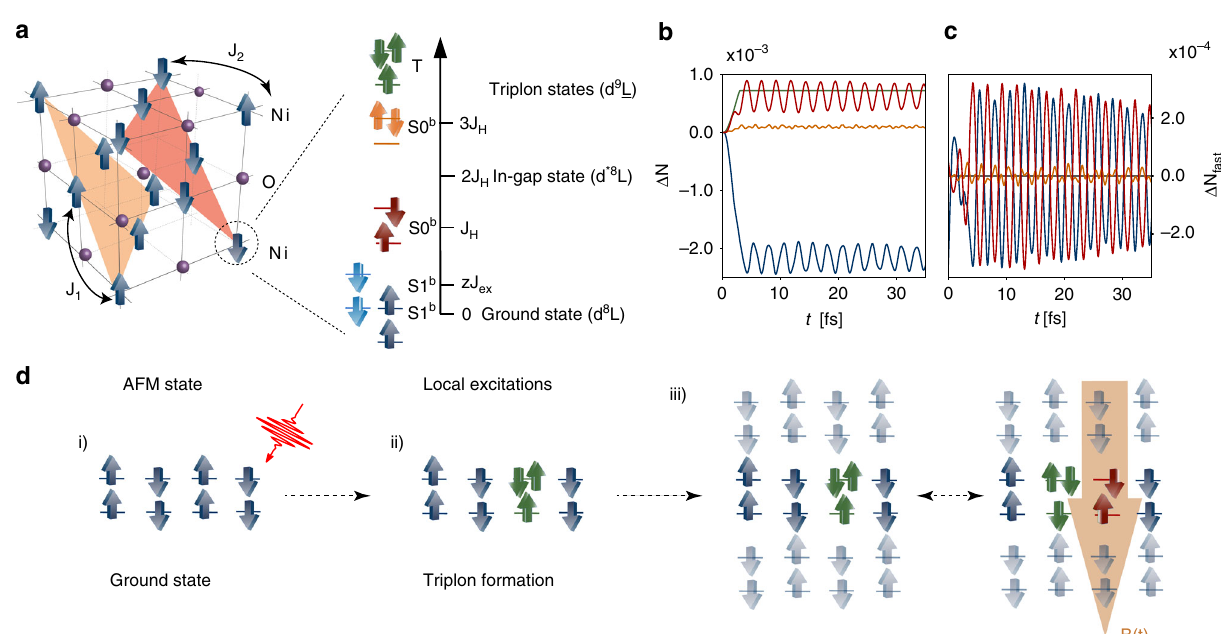
Fig. 5 Coherent many-body dynamics. a Schematic view of the NiO lattice structure with FM exchange J 1 between the nearest-neighbor spins and AFM exchange J 2 between next-nearest neighbors. The local many-body levels are the triplon (T), majority high-spin doublon (S1), minority high-spin doublon (S1 ♭ ), low-spin Hund excitation with electrons in different orbitals at an energy cost J H (S0), and low-spin Hund excitation with electrons in the same orbital at an energy cost 3 J H (S0 ♭ ). Spin- fl ip excitations such as S1 ♭ are described by the exchange Hamiltonian (2). b Time evolution of the occupation for the most relevant local many-body states, and c the same data with subtracted background dynamics. The colors of the curves match the graphical representation of the local many-body states. d Schematic view of the photo-induced dynamics in NiO: (i) AFM ground state with high-spin (S1) states, (ii) photo-induced state with mobile triplons, (iii) coherent dynamics between two many-body states, where the magnetic background B ( t ) is responsible for the characteristic oscillations whose frequency scales with the strength of the superexchange interaction J ex